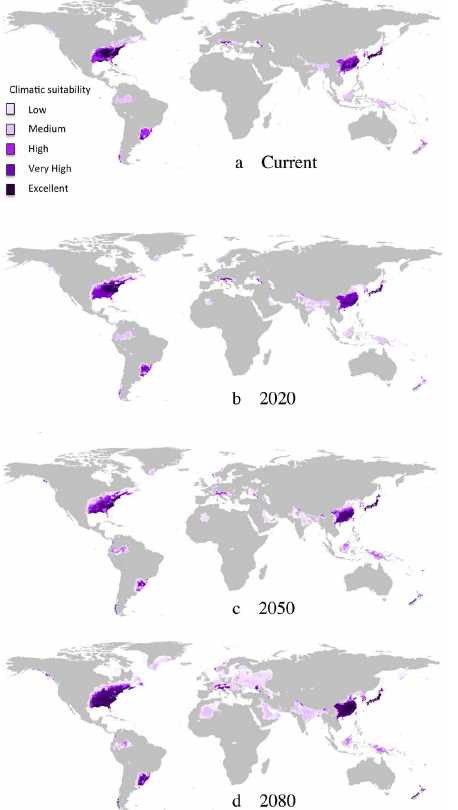
Figure 1. Maps of potential distribution. Climatic suitability ranges from ‘‘low’’ (light purple) to ‘‘excellent’’ (dark purple). ( a ) Current climatic conditions ( b ) Consensus model of 6 future climatic scenarios (3 GCM 6 2 SRES) for 2020, ( c ) 2050 and ( d ) 2080.